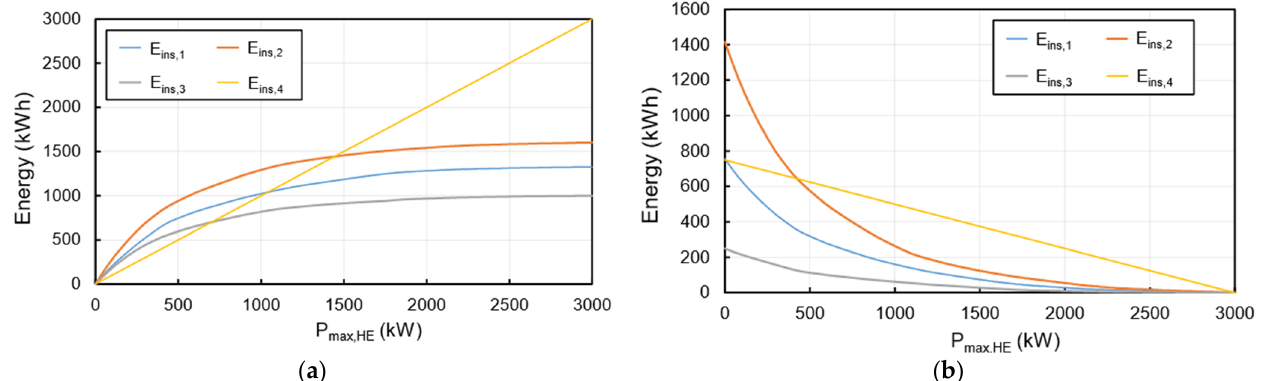
Figure 7. Installed energy based on different design criteria: ( a ) HE battery ( b) HP battery.